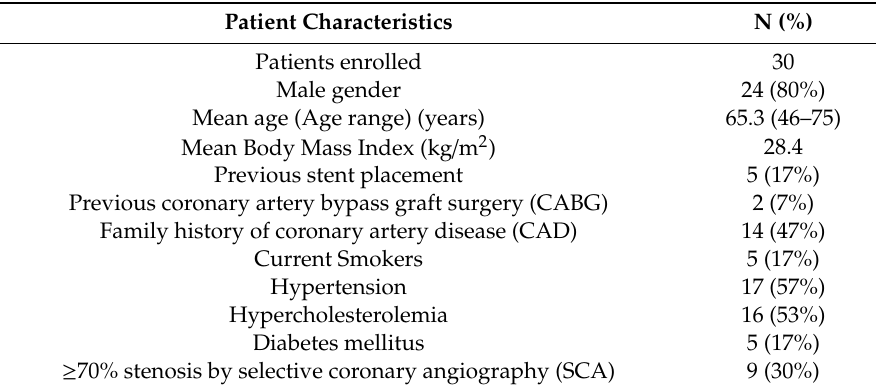
Table 1. Patient characteristics.